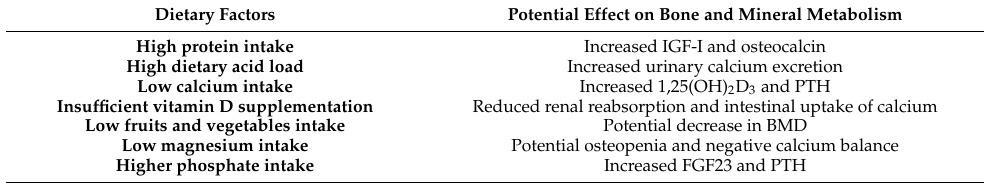
Table 4. Dietary factors associated with an increased risk of SHPT. Dietary